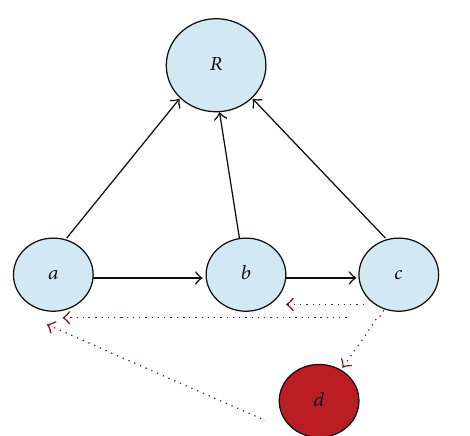
Figure 14: A similar situation happens when a third node is added. And so